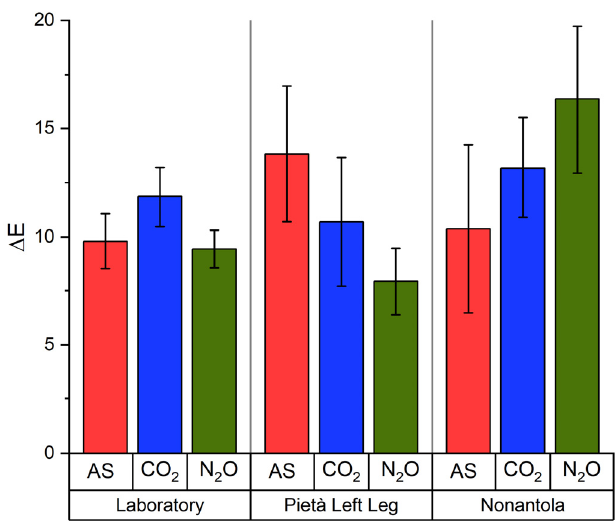
Figure 8. Cleaning performance based on ∆ E * for the different cleaning systems (agar sol/gel—AS; agar CO 2 foam—CO 2 ; and agar N 2 O foam—N 2 O) in laboratory conditions and with two case studies.